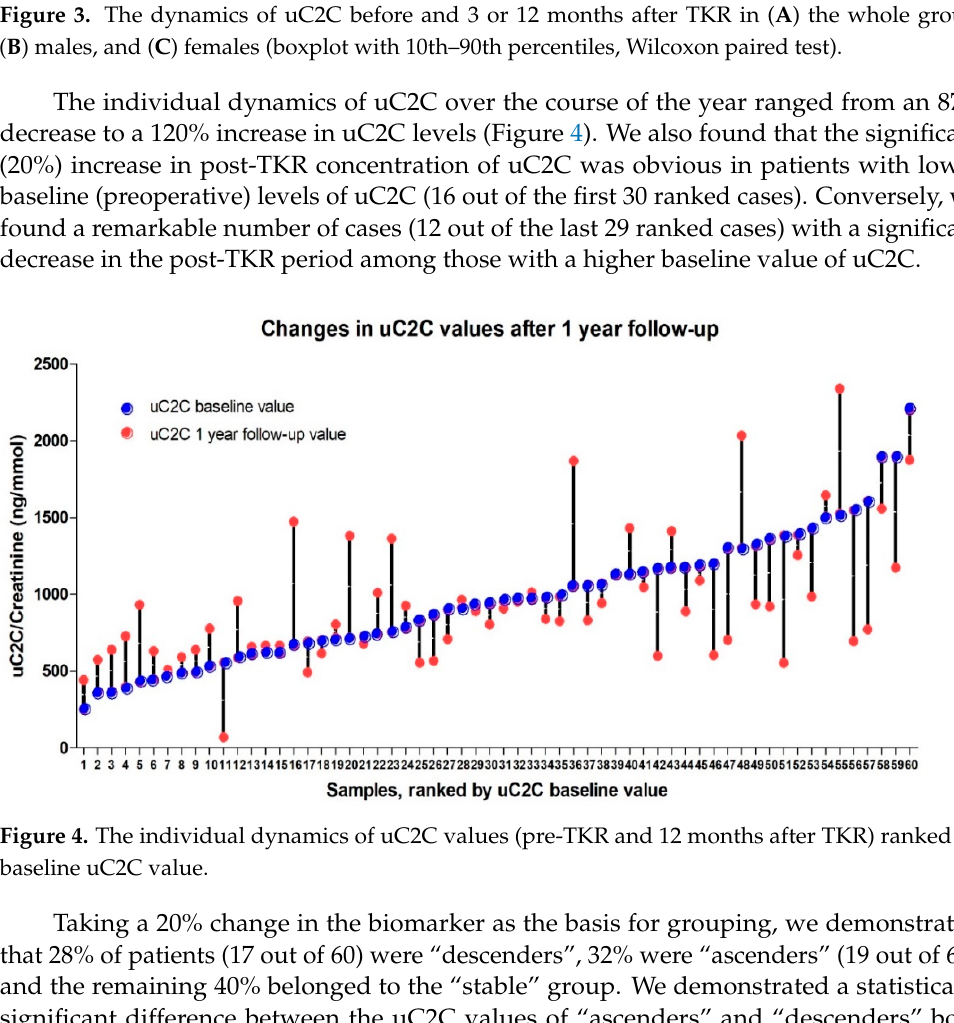
Figure 4. The individual dynamics of uC2C values (pre-TKR and 12 months after TKR) ranked by baseline uC2C value.